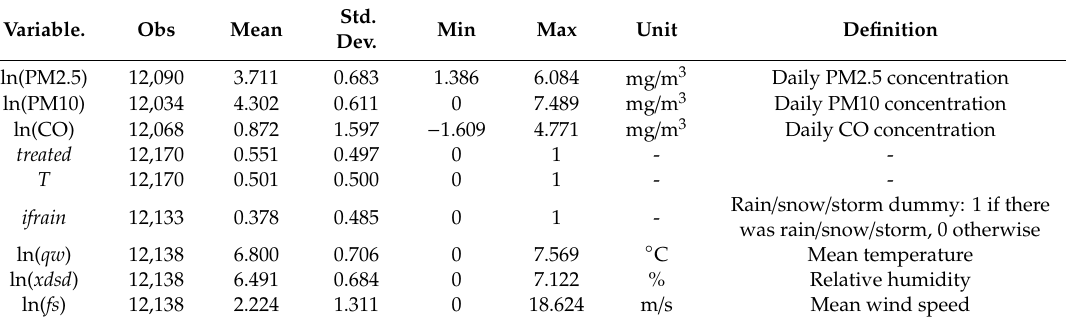
Table 1. Variable definitions and summary statistics.